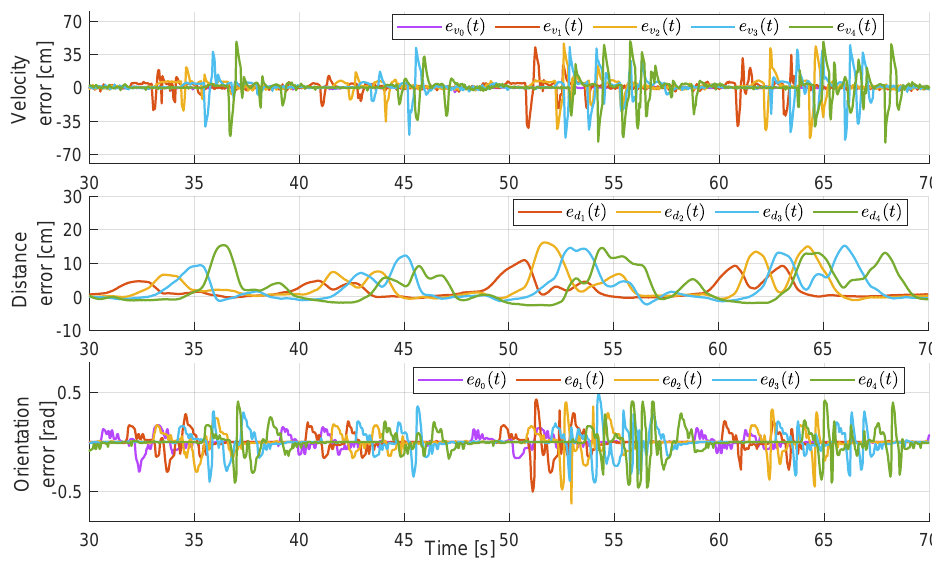
Figure 11. Errors in a time window of the experiment using the non-cooperative strategy. The distance tracking is shown in Figure 9 for each agent, except for the